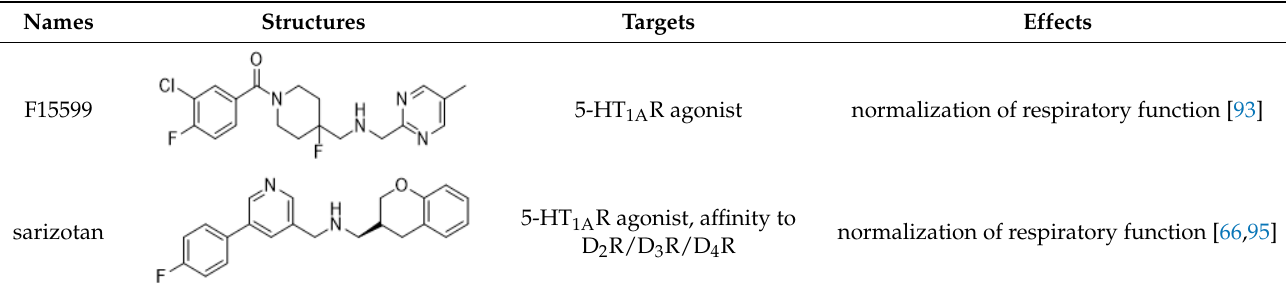
Table 3. Pharmacological agents which have potential effects on RTT treatment.